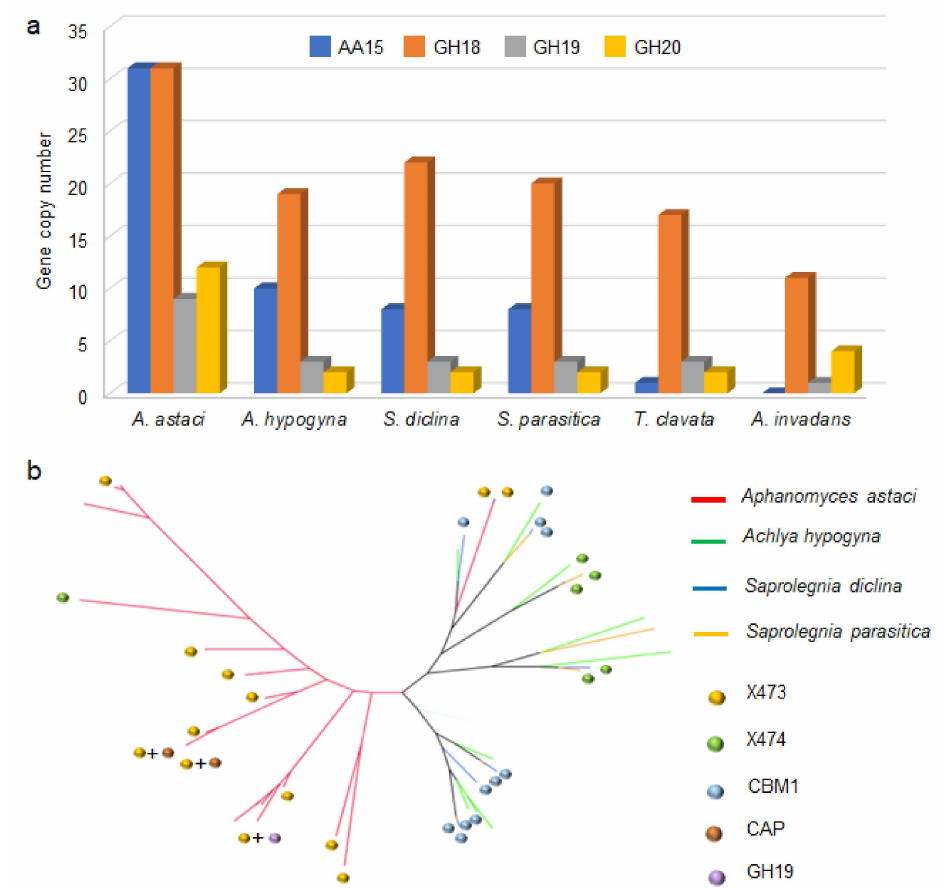
Figure 2. Abundance of chitin-active CAZy families in oomycetes and phylogeny of AA15 LPMOs in zoonotic species. ( a ) Histogram illustrating the number of genes coding for AA15 (Auxiliary Activity Family 15), GH18 (glycoside hydrolase family 18, chitinase), GH19 (glycoside hydrolase family 19, chitinase/lysozyme) and GH20 (glycoside hydrolase family 20, β -N-acetylglucosaminidase) in representative Saprolegniales . ( b ) Maximum likelihood phylogenetic tree of AA15 LPMOs (catalytic domain only) from four major zoonotic Saprolegniales species ( A. astaci , A. hypogyna , S. diclina and S. parasitica ). Annotations indicate additional domains C-terminally fused to the AA15 domain. The most common extension of AA15s in A. hypogyna , S. diclina and S. parasitica is represented by CBM1, while in A. astaci it is X473. CBM1: carbohydrate binding module 1 (cellulose specific). CAP: cysteine-rich secretory proteins, antigen 5 and pathogenesis-related 1 proteins